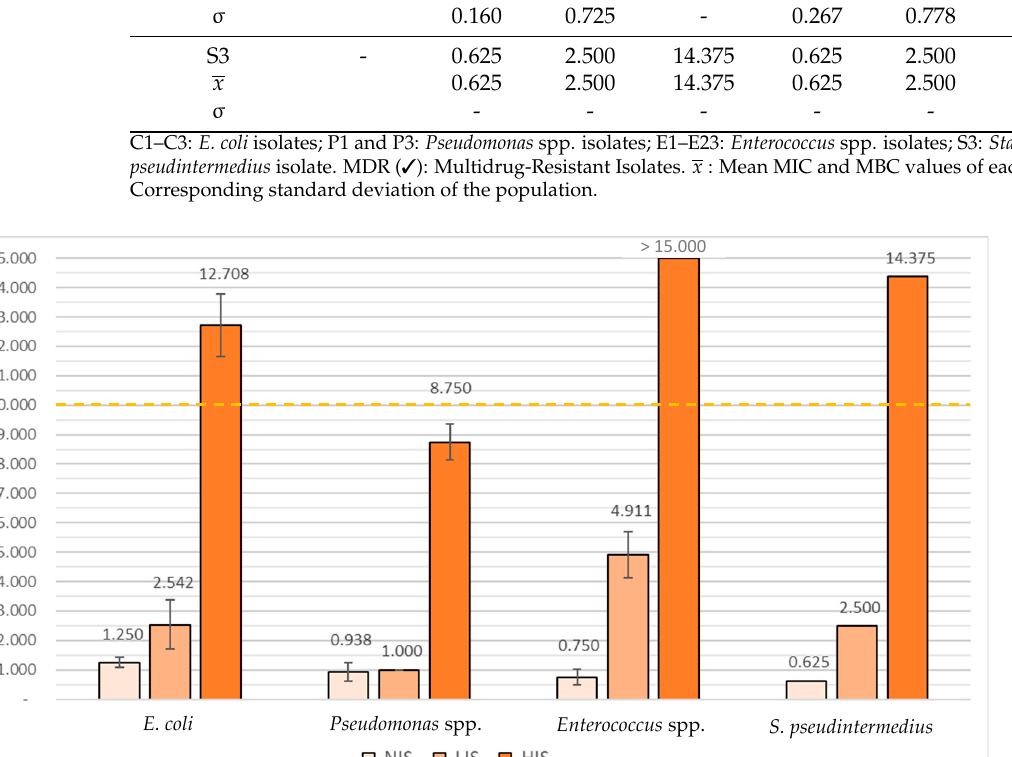
Pseudomonas spp.